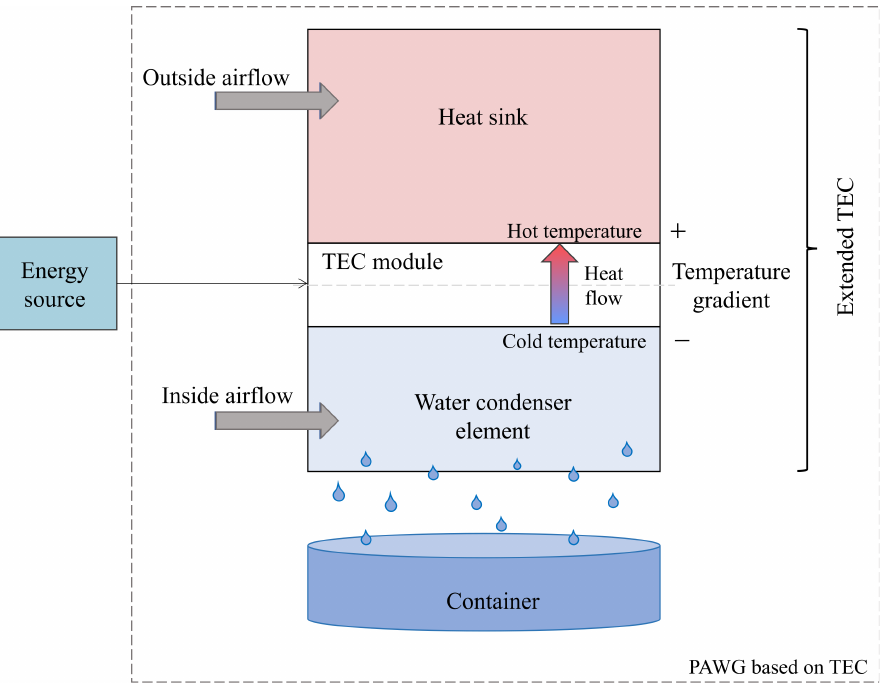
Figure 1. Structure of an Portable Atmospheric Water Generator (PAWG) prototype based on Thermoelectric Cooler